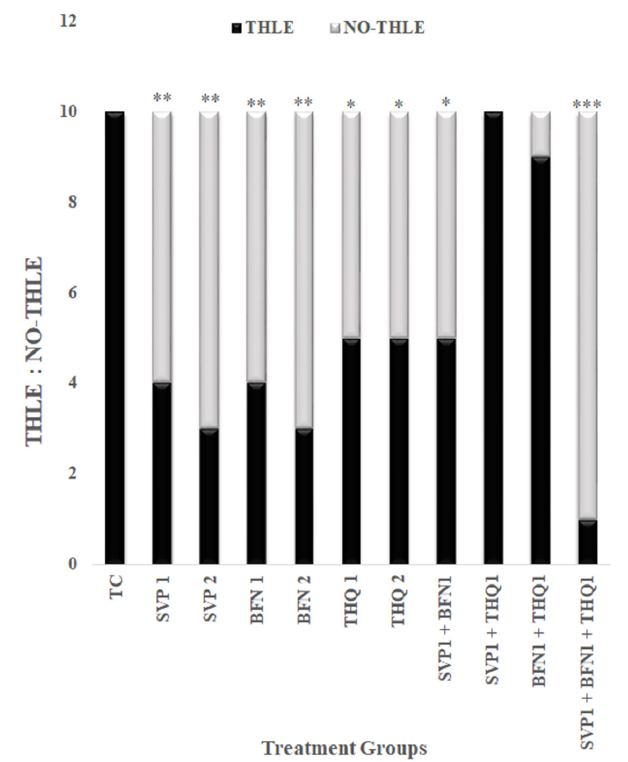
Figure 1. Effect of SVP (150 and 300 mg/kg), BFN (5 and 10 mg/kg), THQ (40 and 80 mg/kg) alone and in low dose combination on MES induced THLE. The values are expressed as ratio of THLE:NO ‐ THLE. * p < 0.05, ** p < 0.01, *** p < 0.001 versus toxic control rats. Fisher’s exact test (2 × 2 contingency table; One tailed) was used for statistical analysis.